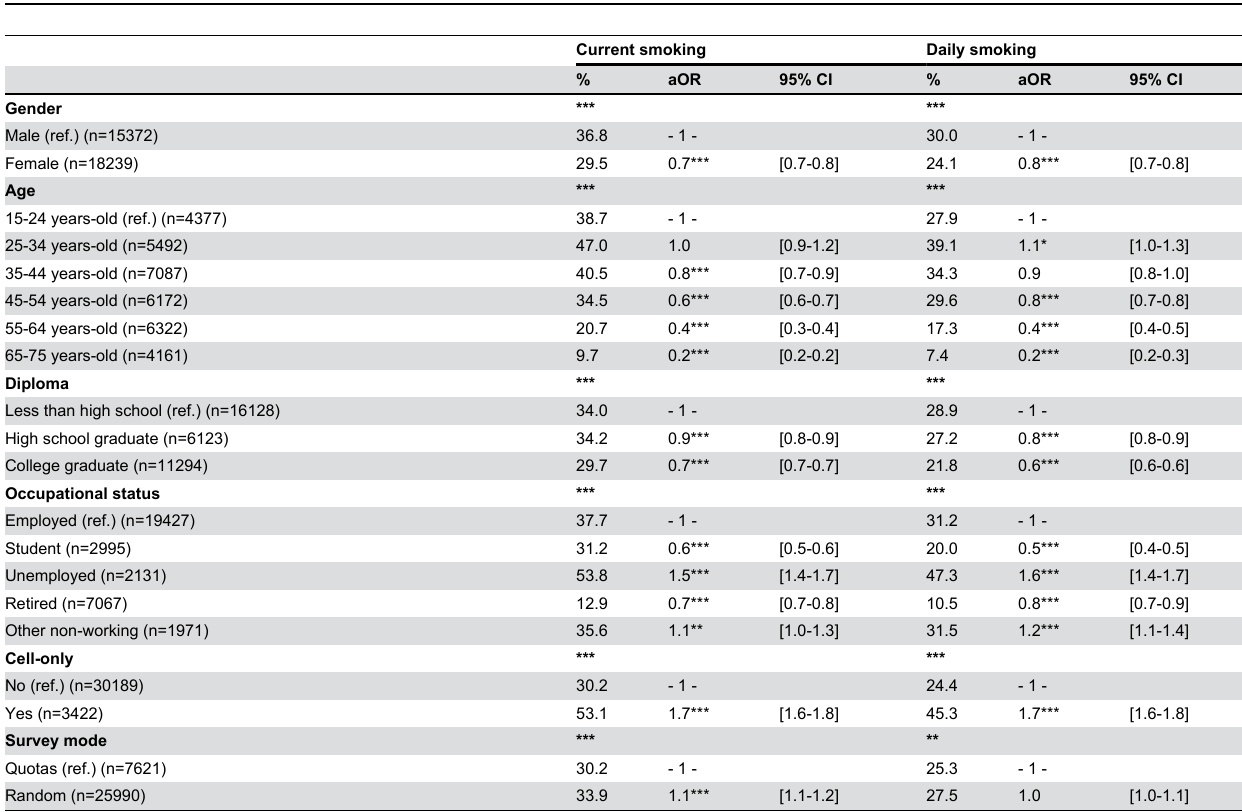
Table 4. Weighted percentages, adjusted odds-ratios (aOR) and 95% confidence intervals (CI) from logistic regressions on current and daily smoking among the whole of respondents